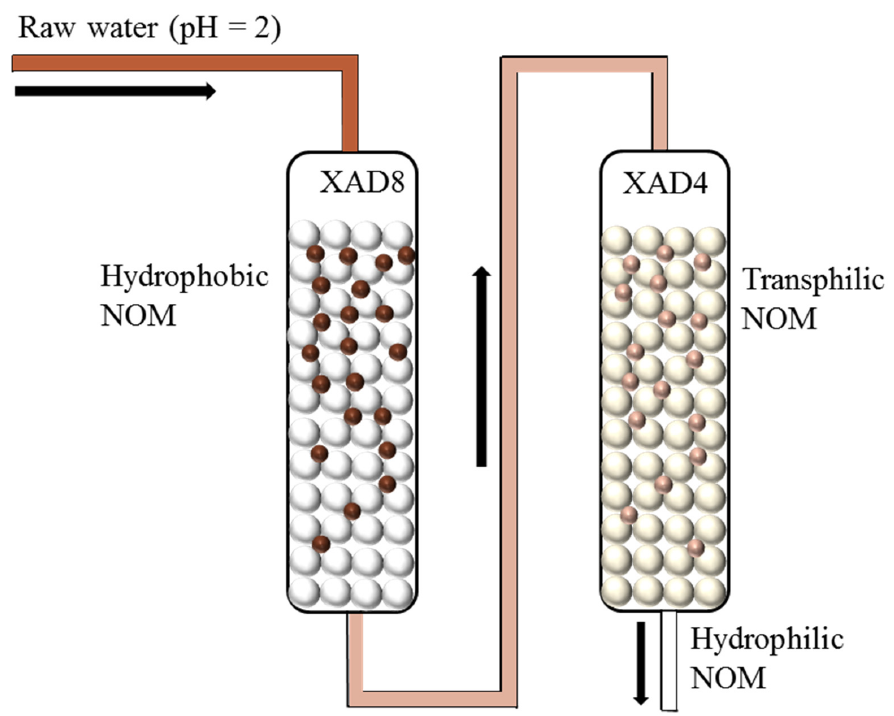
Figure 1. Schematic concept for the isolation of dissolved organic matter (DOM) using XAD 8 and XAD 4 resins.